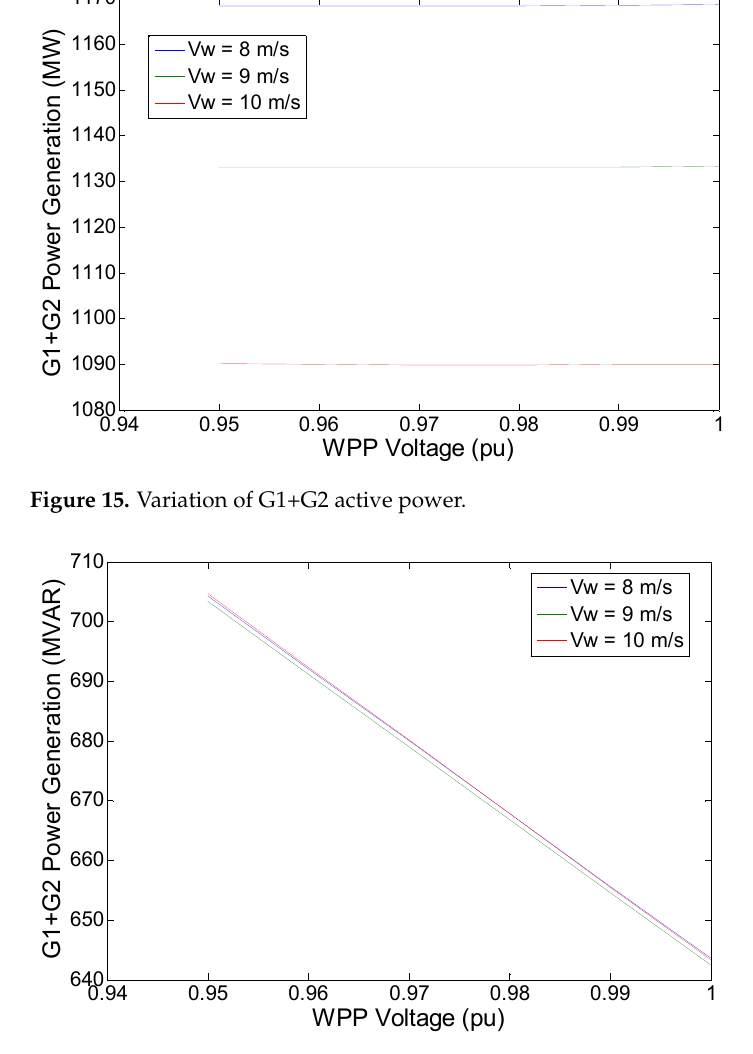
Figure 16. Variation of G1+G2 reactive power.